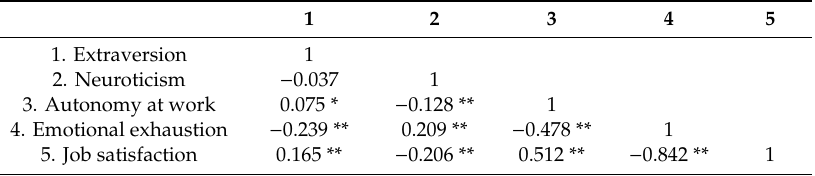
Table 1. Pearson correlation matrix between the study